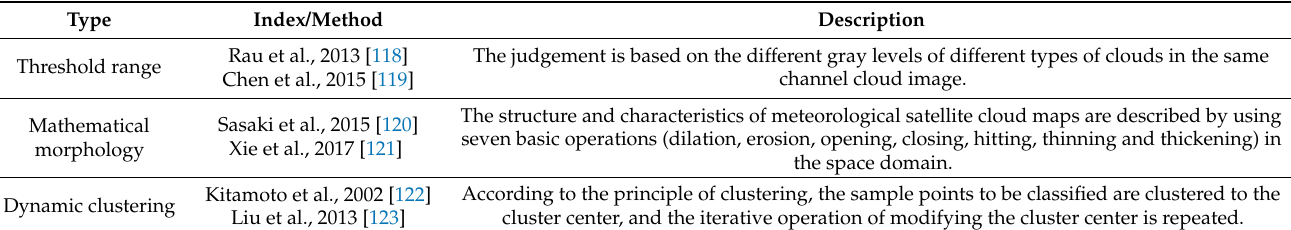
Table 7. Information extraction of